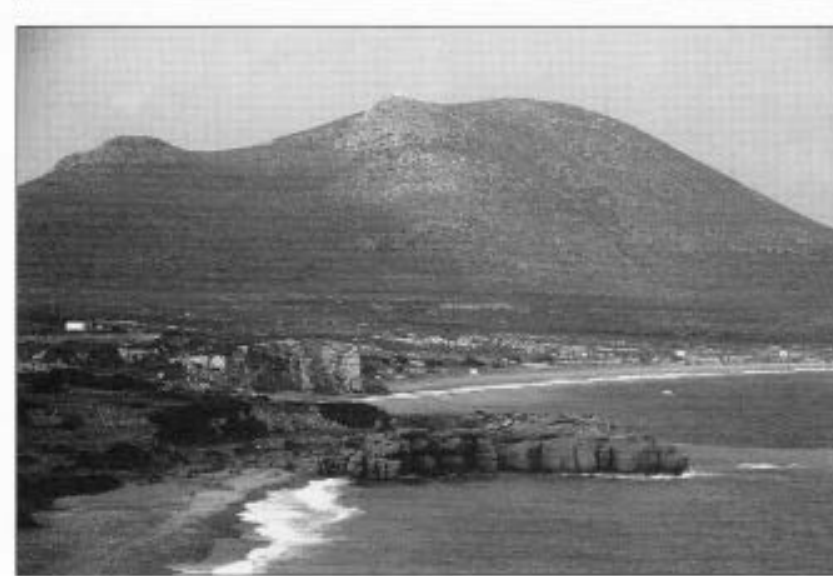
Figure 2 View of the site of Kastri, located on the promontory in the foreground, with the peak sanctuary of Agios Georgios on the summit of the mountain in the distance. ultimate stylistic origins lie to the north, on the Peloponnesian mainland. In exactly what sense this pre-palatial Minoan pottery makes Kastri the oldest Minoan colony in the Aegean remains open to debate. But clearly, the demographic and social